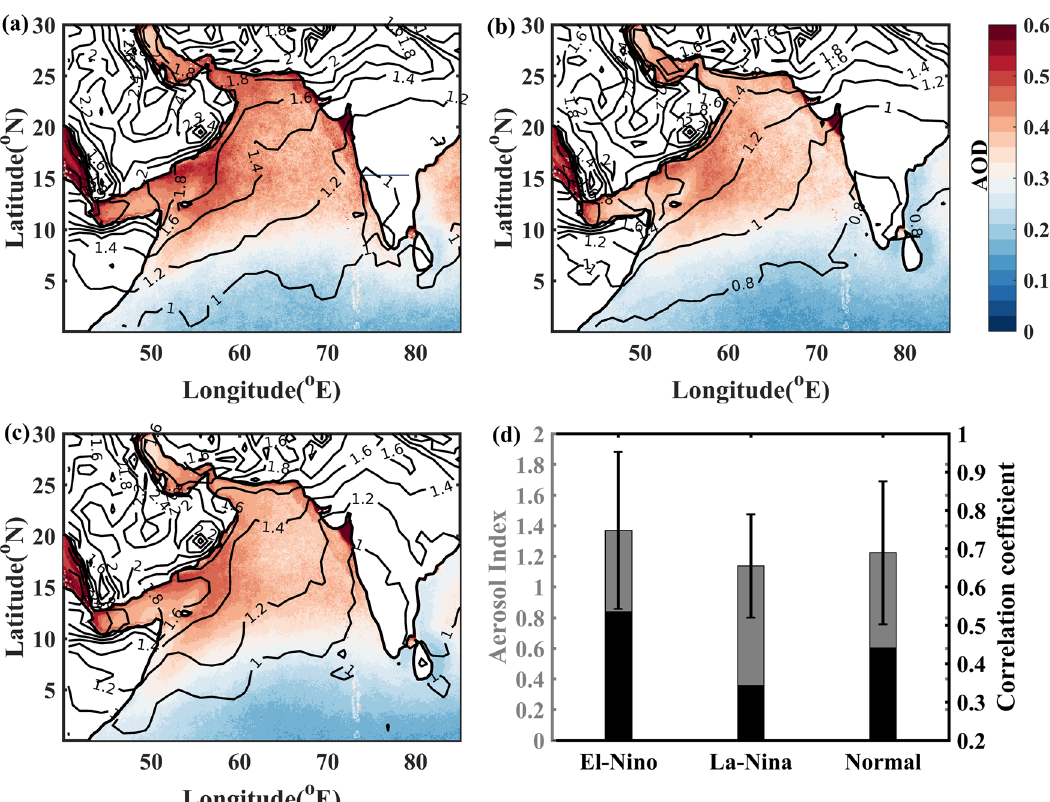
Fig. 2 Spatial pattern of AOD and Aerosol Index over the AS. a El-Nino, b La-Nina and c Normal years. The colour bar shows the AOD, and the contour lines indicate AI. d The black bar represents the correlation coef fi cient calculated for weekly mean AOD over the AS(10 – 25°N and 50 – 75°E) and the CI region separately for El-Nino (7 years, sample size n = 121), La-Nina (8 years, n = 139) and Normal years ( n = 309) during the period 1981 – 2013. The grey bars represent the Spatio-temporal mean of AI over the AS and one standard deviation. Values of correlation coef fi cients are statistically signi fi cant above 95% con fi dence